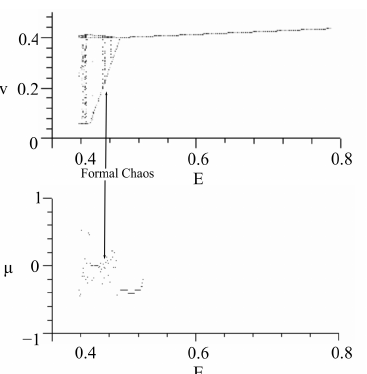
Figure 16. Bifurcation diagram with E parameter.